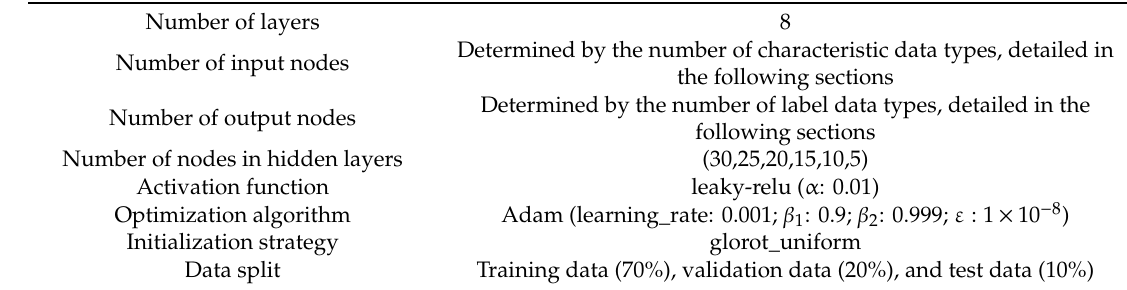
Table 1. Neural network parameter